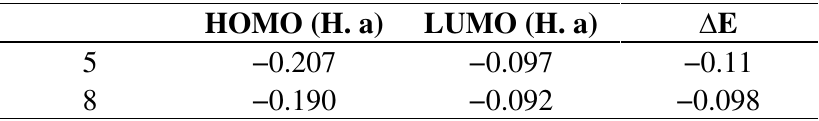
Table 2. HOMO and LUMO energies of 5 and 8 .